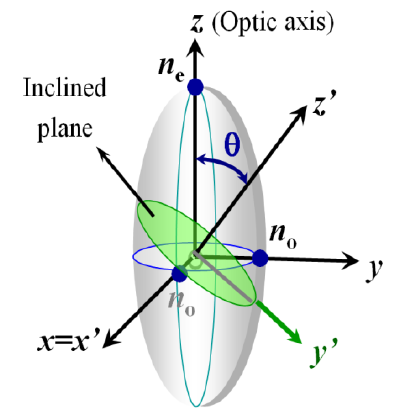
Figure 3. Light propagation in uniaxial mediums.